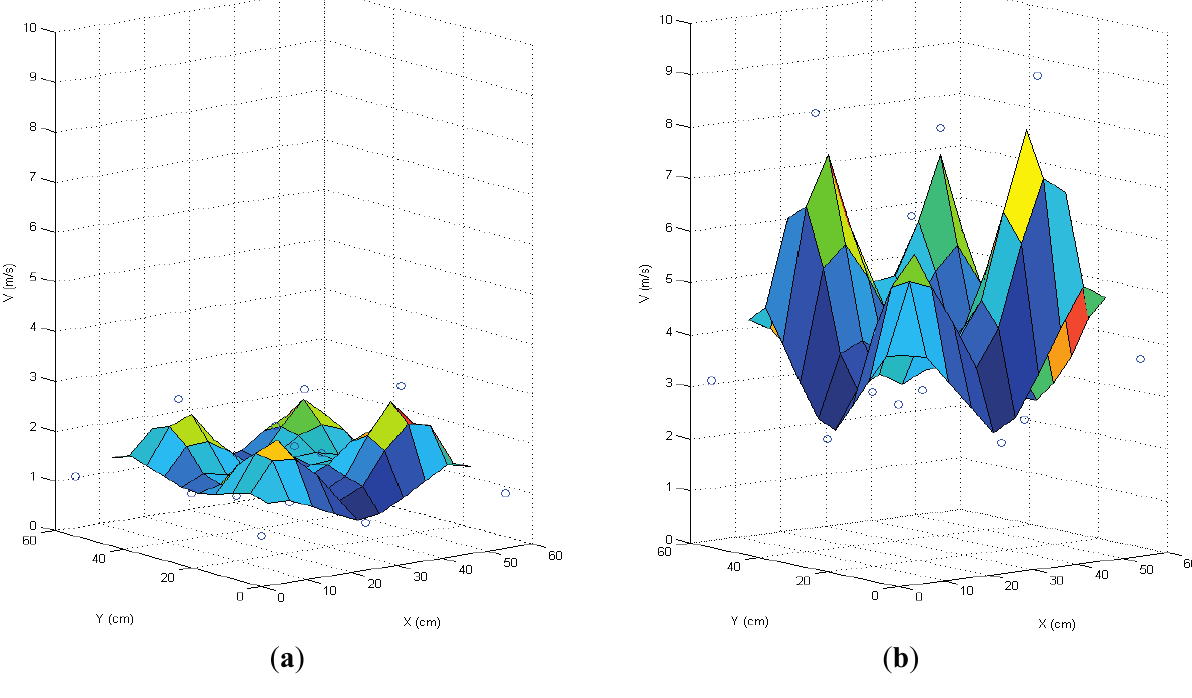
Figure 7. ( a ) Air speed over the quadrotor; ( b ) Air speed under the quadrotor.